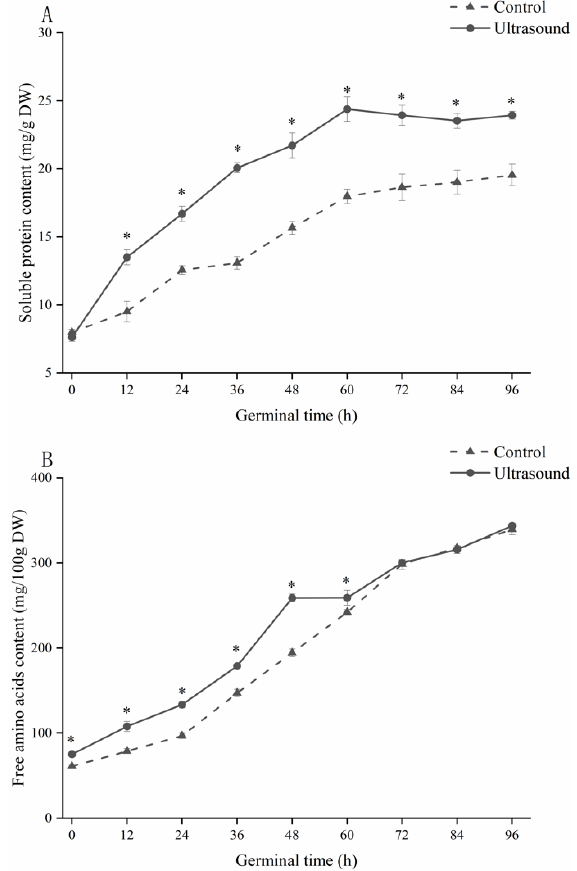
Figure 4. The effect of ultrasound induction treatment on soluble protein content ( A ) and free amino acid content ( B ) during maize germination. * Indicates a significant difference ( p < 0.05) between the ultrasound and control